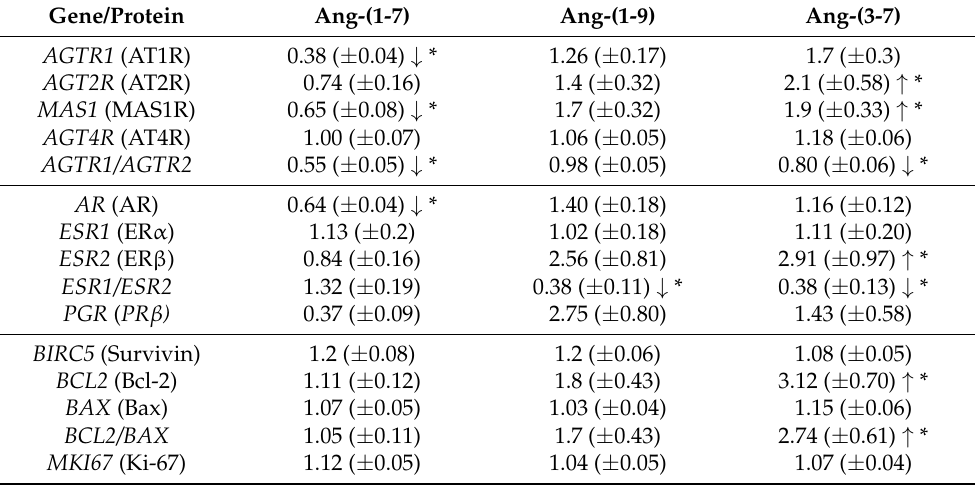
Figure 2. ( A ) The Alamar Blue Assay results, following the incubation (48 h) of ovarian cancer cells with tested angiotensins in the medium with or without FBS. ( B ) The Muse ® Ki67 Proliferation Assay results following the incubation (48 h) of ovarian cancer cells with 0.1 nM angiotensins in the medium without FBS (mean ± SD; one-way ANOVA with Tukey’s test: * p < 0.05). Table 1. The fold change values for RT-qPCR results (treatment vs. control), following the incubation (48 h) of OVPA8 cells with tested angiotensins in the medium without FBS (mean ± SEM; one-way ANOVA with Dunnett’s test: * p < 0.05; ↓ —down-regulation gene; ↑ —up-regulation gene).